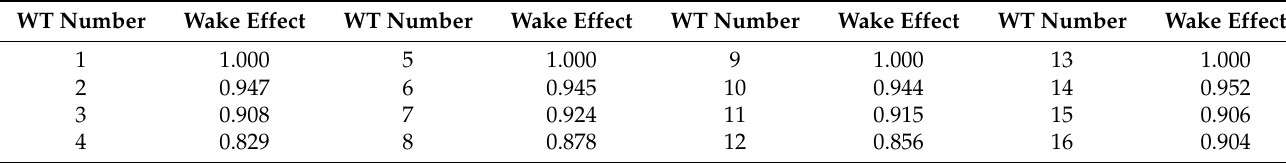
Table 2. Calculation results of wake effect under a wind direction.